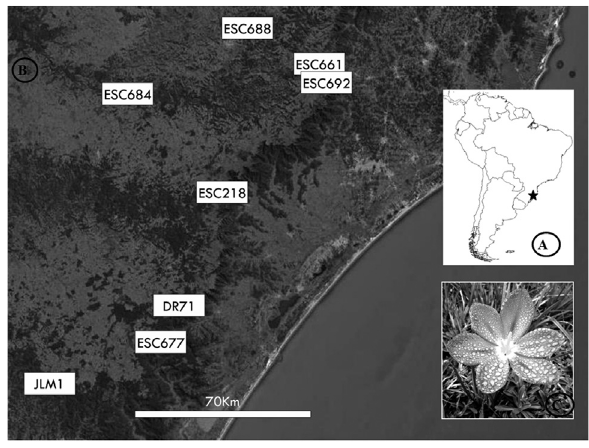
Figure1 -Locationsofthestudiedsamplingsitesof Calydoreacrocoides . A) map of South America; B) sampling sites in southern Brazil; C) Calydorea crocoides . Photograph: J.